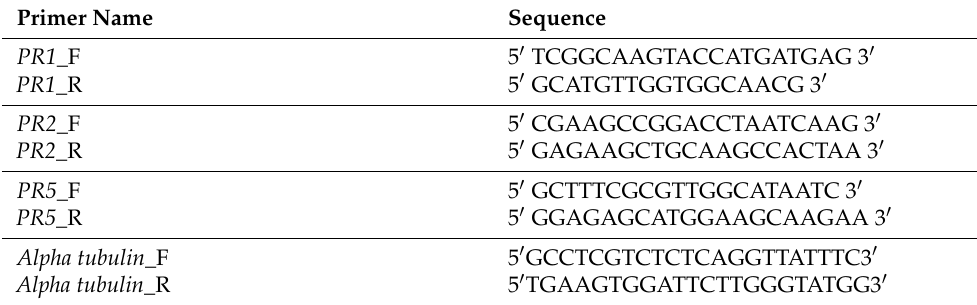
Table 1. List of primers used in this